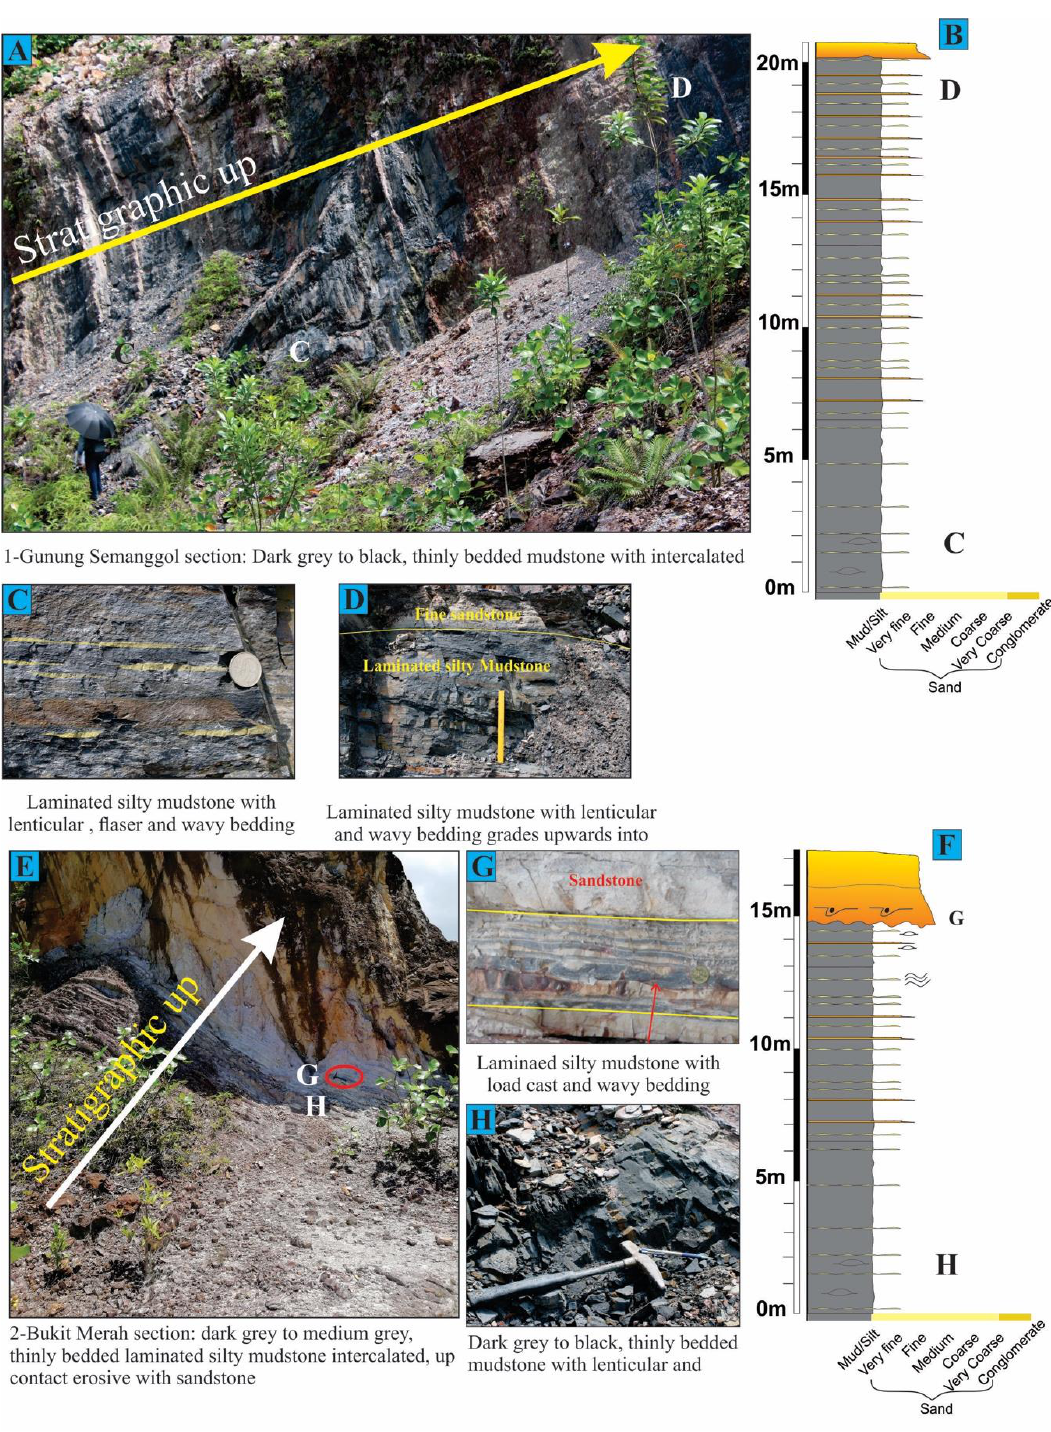
Figure 3. ( A – D ) Stratigraphic log and field photographs of the Semanggol Formation,